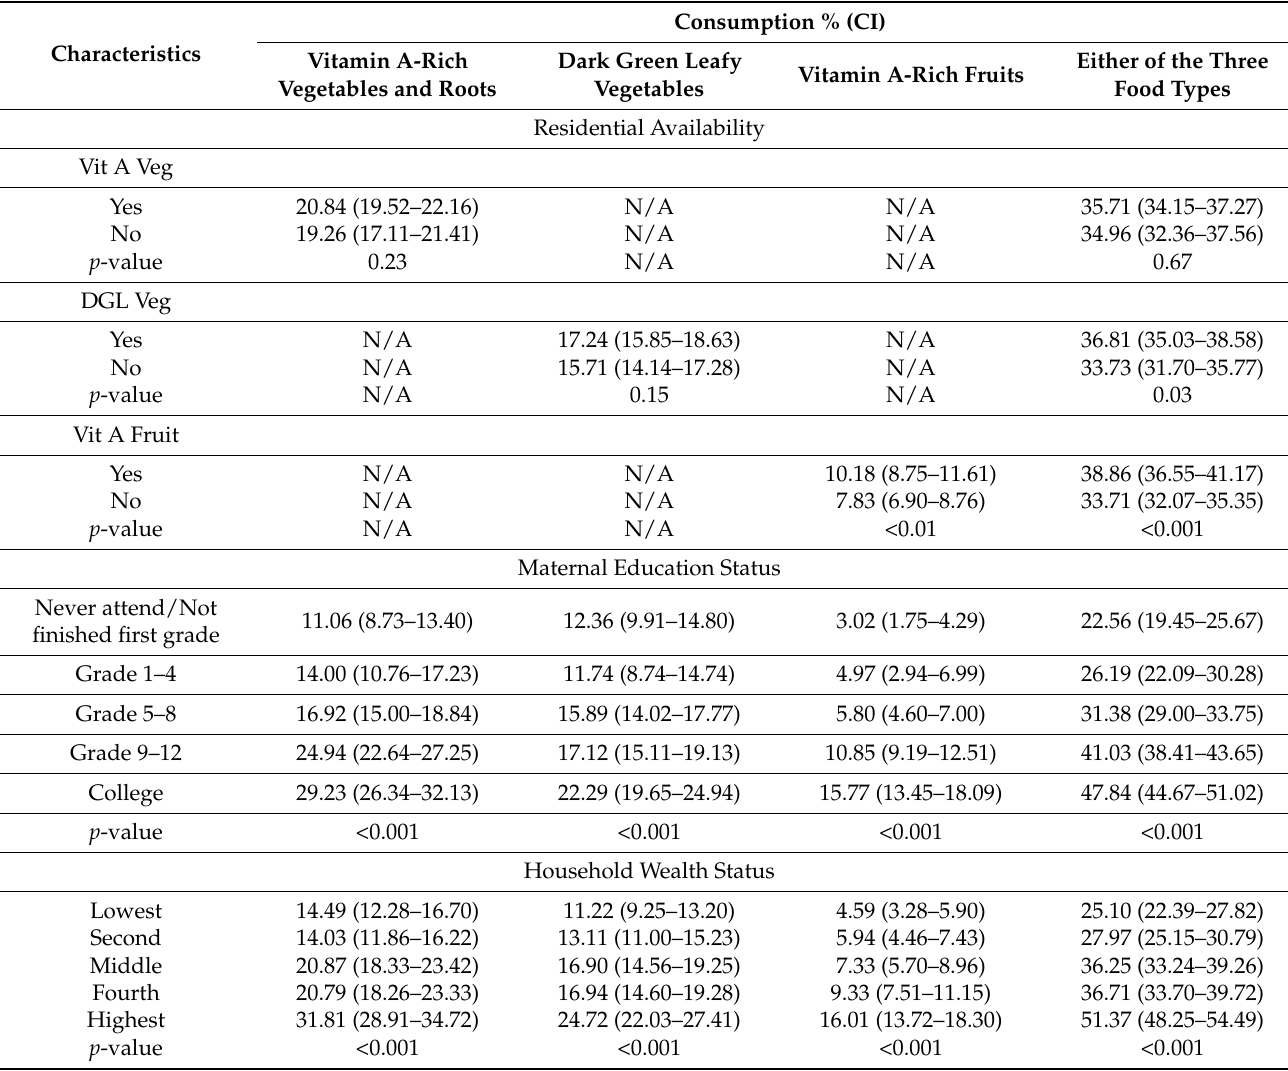
Table 3. Children consumption of vitamin A-rich plant sources food by residential availability of any plant-based vitamin A-rich food and socio-economic status (N = 4911) in Addis